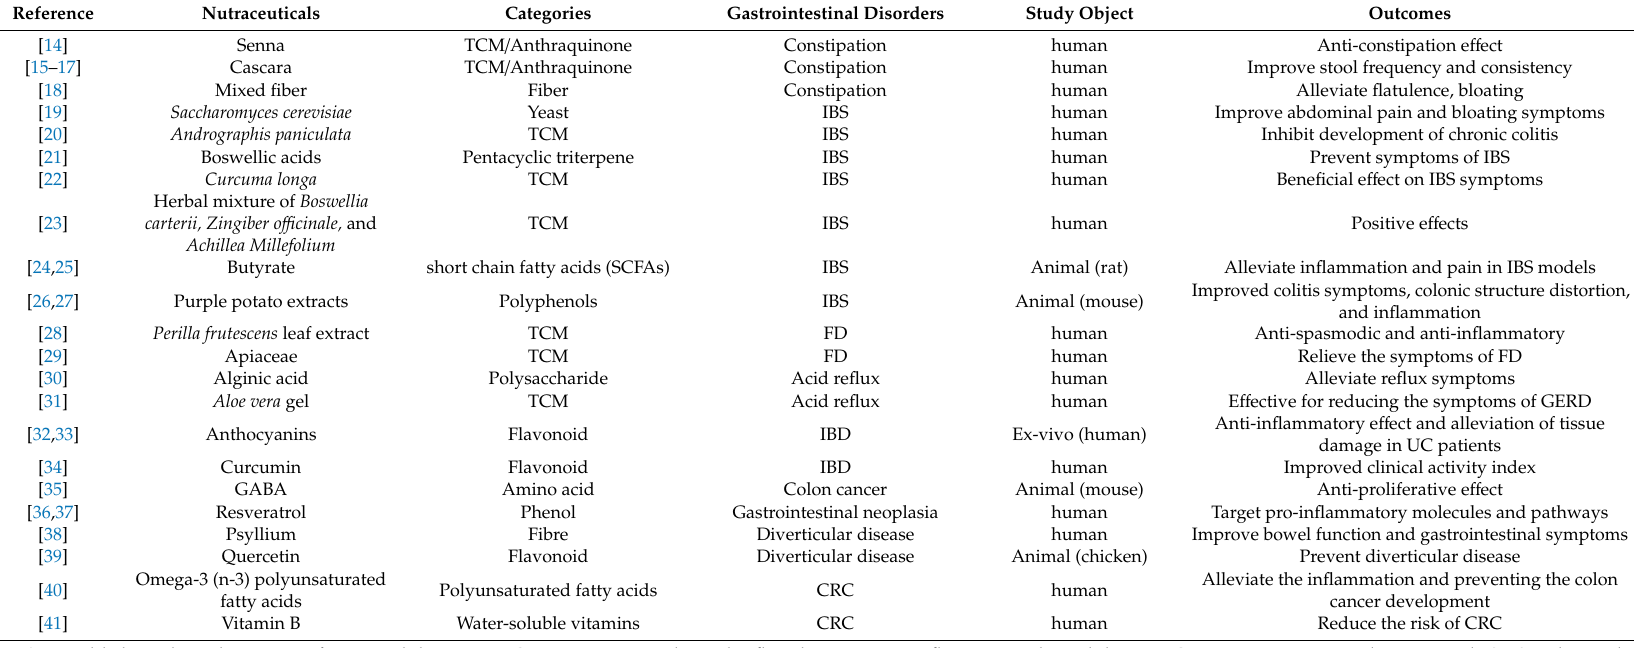
Table 1. Nutraceuticals for Gastrointestinal